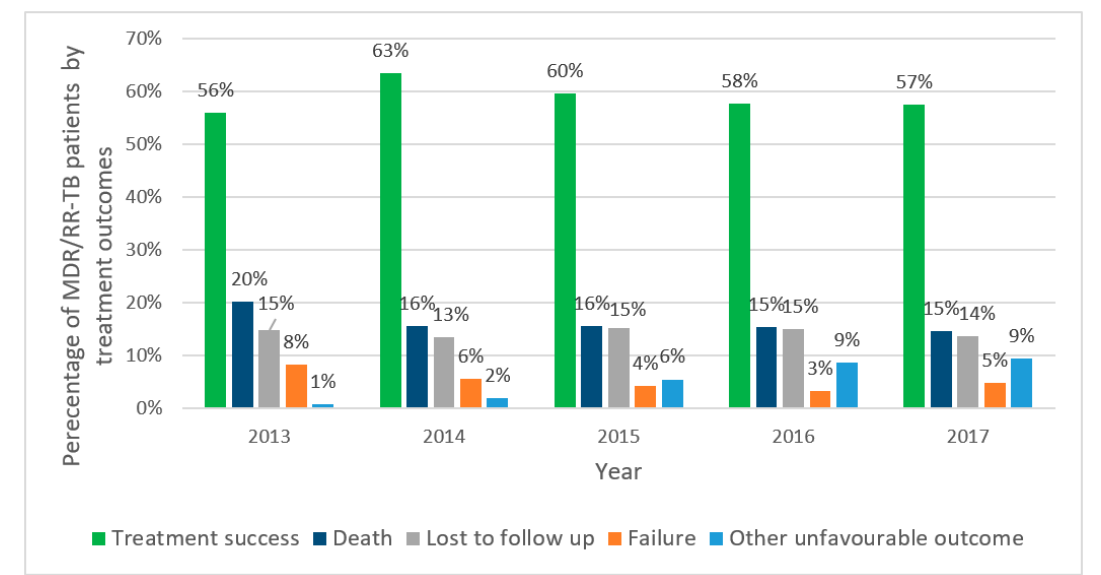
Figure 2. Treatment outcomes of MDR/RR-TB patients enrolled in MDR-TB treatment in Uzbekistan between 2013 and 2017. TB = tuberculosis; MDR-TB = multidrug-resistant TB; RR-TB = rifampicin resistant TB; other unfavorable outcome—continues on treatment up to and after surgery or changed to XDR-TB treatment.